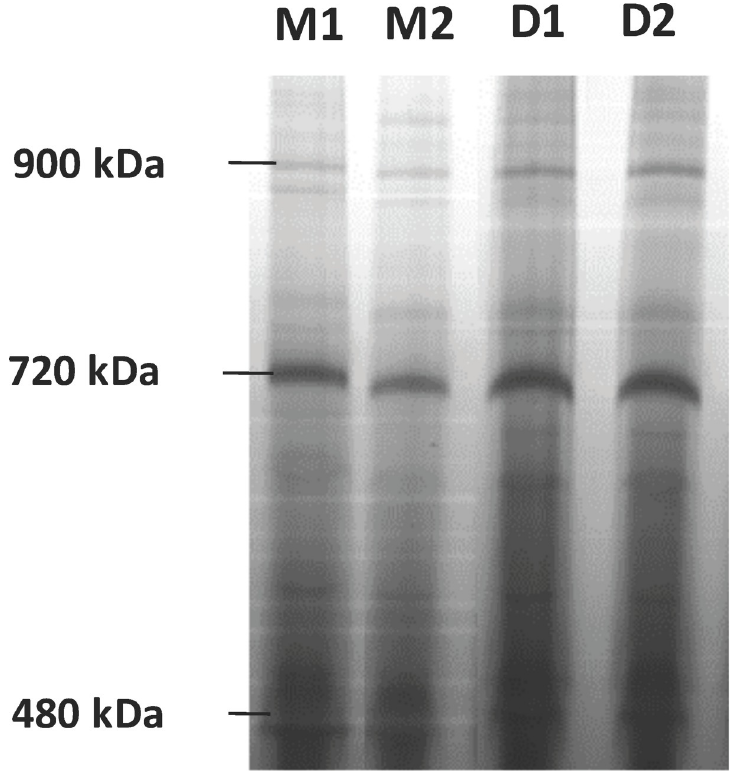
Fig 1. Separation of mitochondrial protein complexes by BN-PAGE by breed and diet (M = Merino, D = Damara, 1 = Restricted, 2 = Unrestricted). Proteins were solubilized with the detergent digitonin at 2% w/v. Gel stained with Coomassie Blue Colloidal. All gel bands at 480 kDa were excised and analyzed by nano-LC-MS/MS.